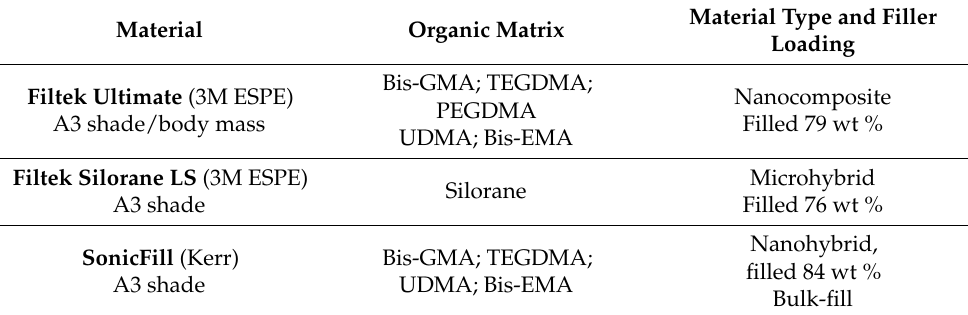
Table 1. Materials included in the